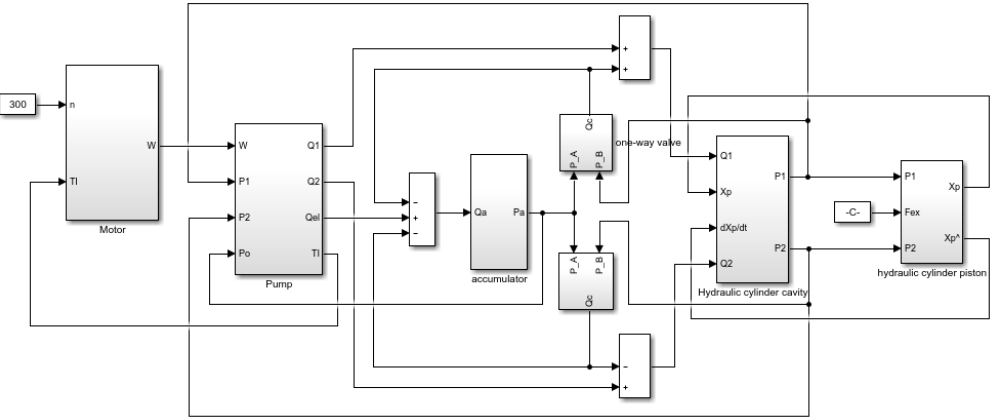
Figure 7. EHA system simulation model. Table 2. EHA simulation model